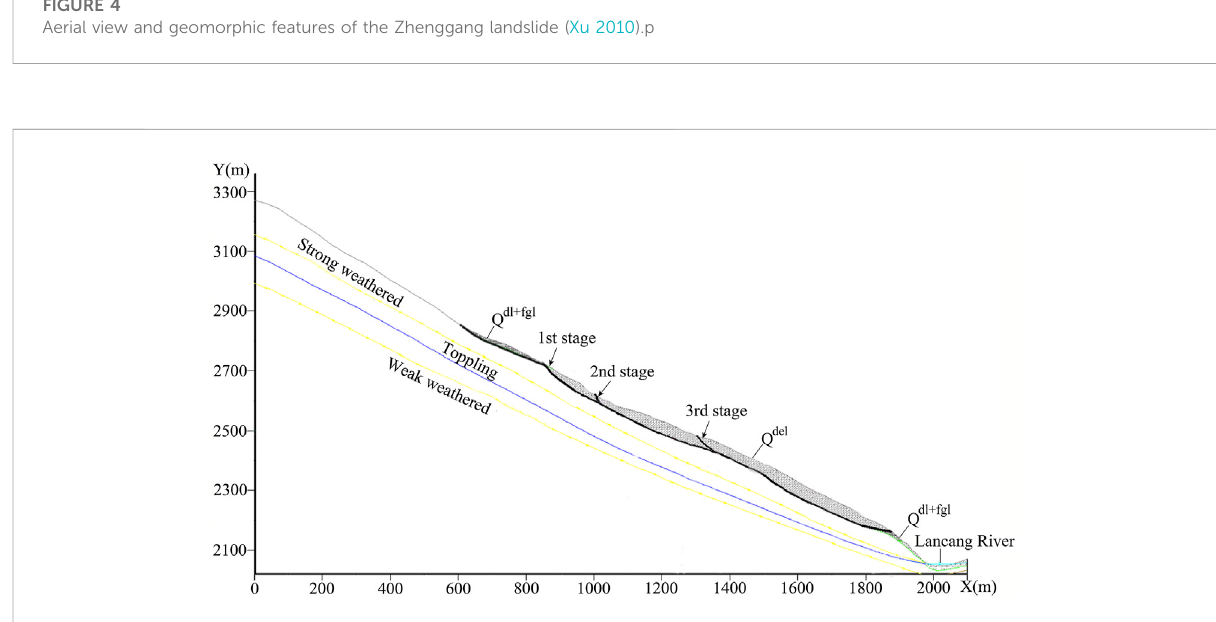
FIGURE 5 A typical pro fi le of the Zhenggang landslide with three sliding